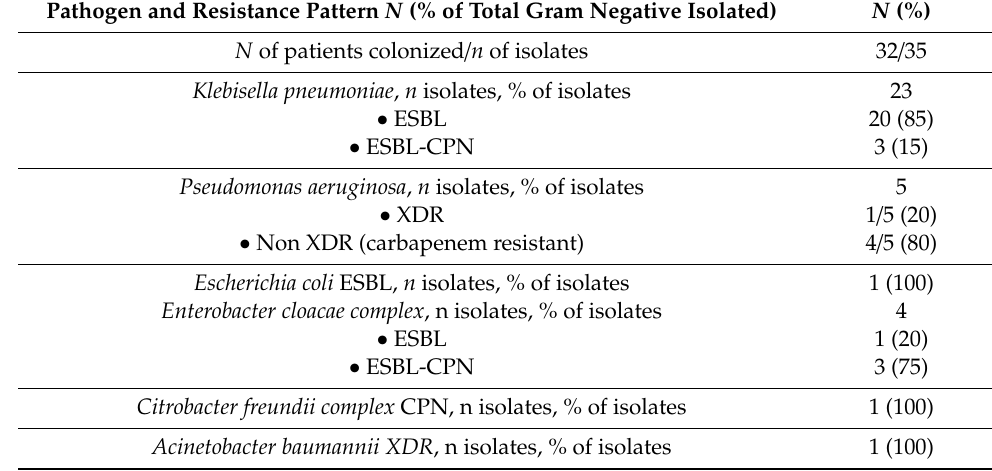
Table 2. Isolated multidrug resistant Gram negative bacteria in surveillance cultures. ESBL: Extended Spectrum Beta-Lactamase producing. ESBL-CPN: Extended Spectrum Beta-Lactamase and carbapenemase producing. XDR: Extremely Drug Resistant.